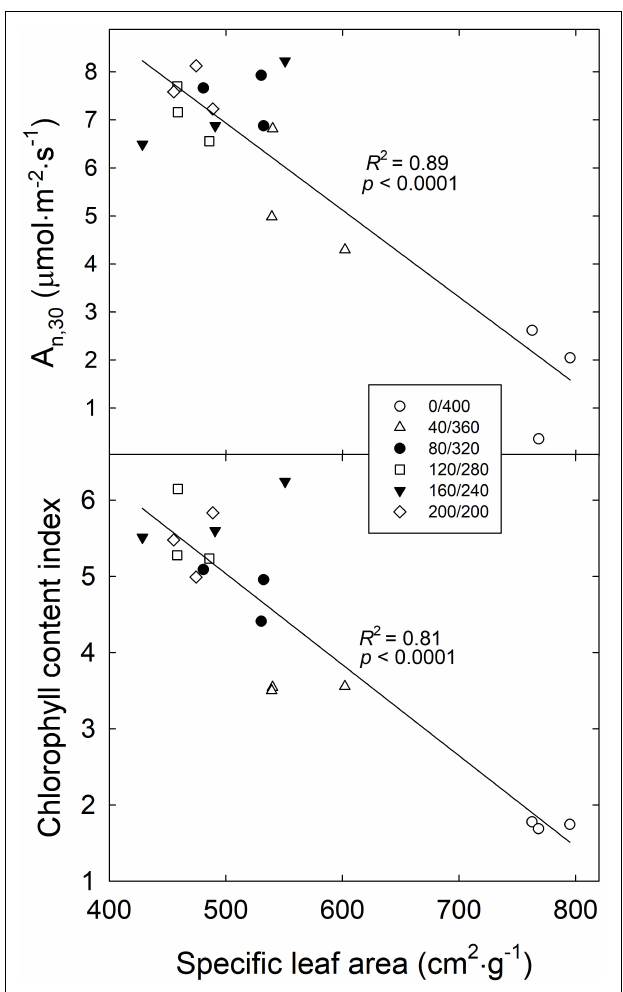
FIGURE 7 | Average net photosynthesis over a 30 min period (A n , 30 ) and chlorophyll content index of ‘Green Salad Bowl’ lettuce ( Lactuca sativa ) as a function of specific leaf area. Symbols represent each treatment, with three replications per treatment. Plants were grown and measured under fluctuating PPFD, changing every 15 min between high and low PPFD ( ∼ 400/0, 360/40, 320/80, 280/120, 240/160, and 200/200 µ mol · m − 2 · s − 1